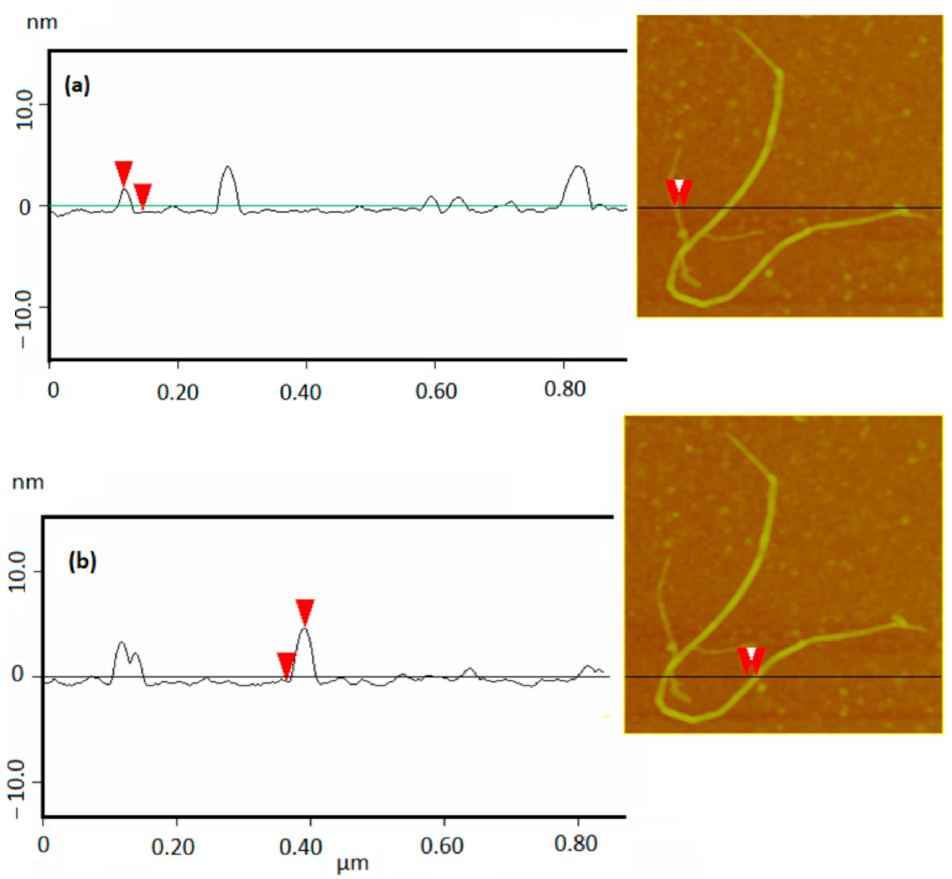
Figure 4. Images from atomic force microscopy (AFM) of the CNWs sample (right) and its topographical profile in ( a , b ). profile in ( a , b